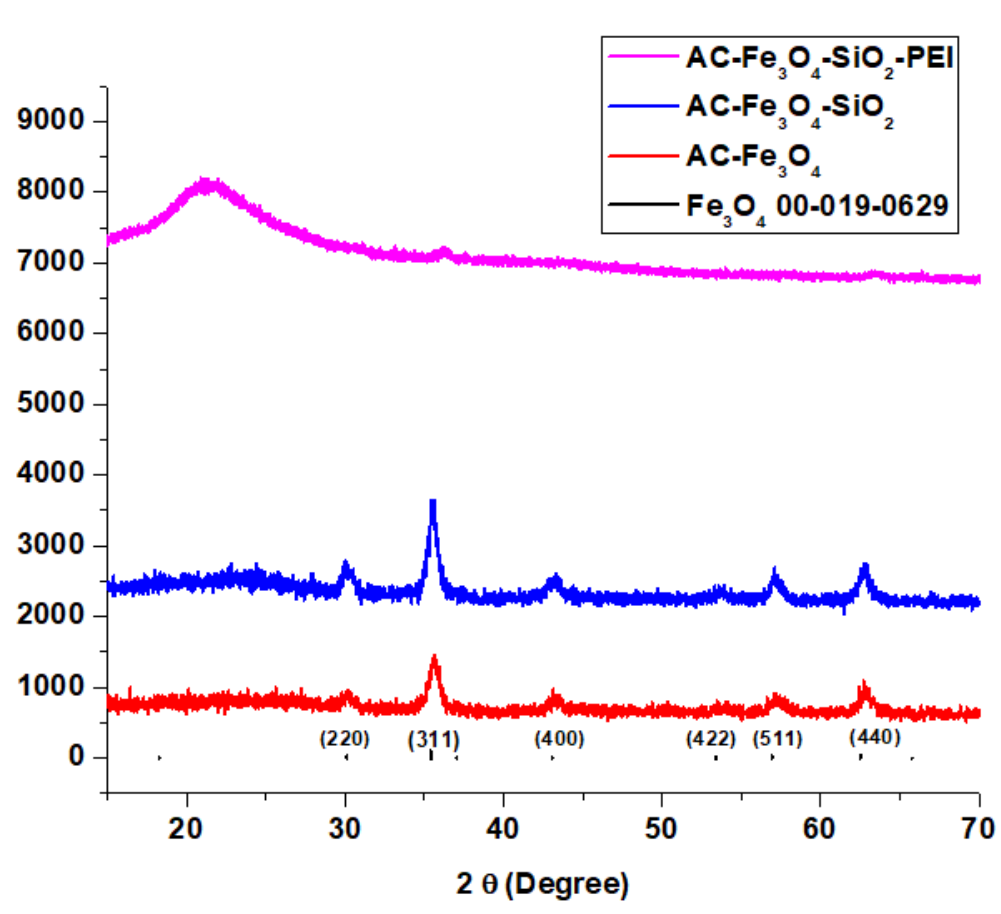
Figure 3. X-ray diffraction spectra of AC-Fe 3 O 4 , AC-Fe 3 O 4 -SiO 2, and AC-Fe 3 O 4 -SiO 2 -PEI.